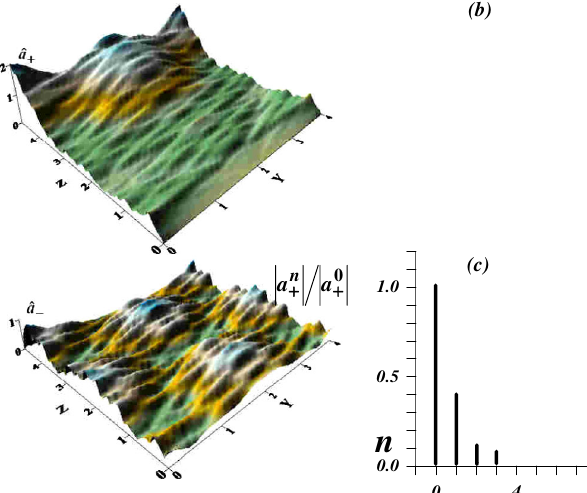
FIG. 6. Spatial distributions of partial wave fields a (cid:4) ð Y; Z Þ [(a),(b)] and the expansion of the output wave beam into series of the regular waveguide modes (c) in the steady-state regime ¼ 0 : 4 , L 0 ¼ 4 , (cid:4) 1 ¼ 1 , (cid:4) 2 ¼ 0 : 5 , (cid:2) ¼ (cid:2) 1 ( B ¼ 4 , L 1 ; 2